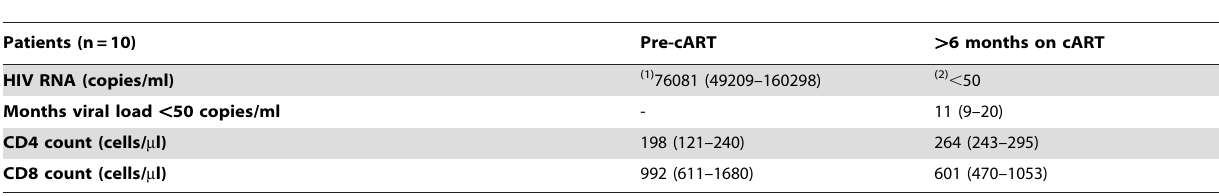
Table 1. Characteristics of longitudinal study participants.